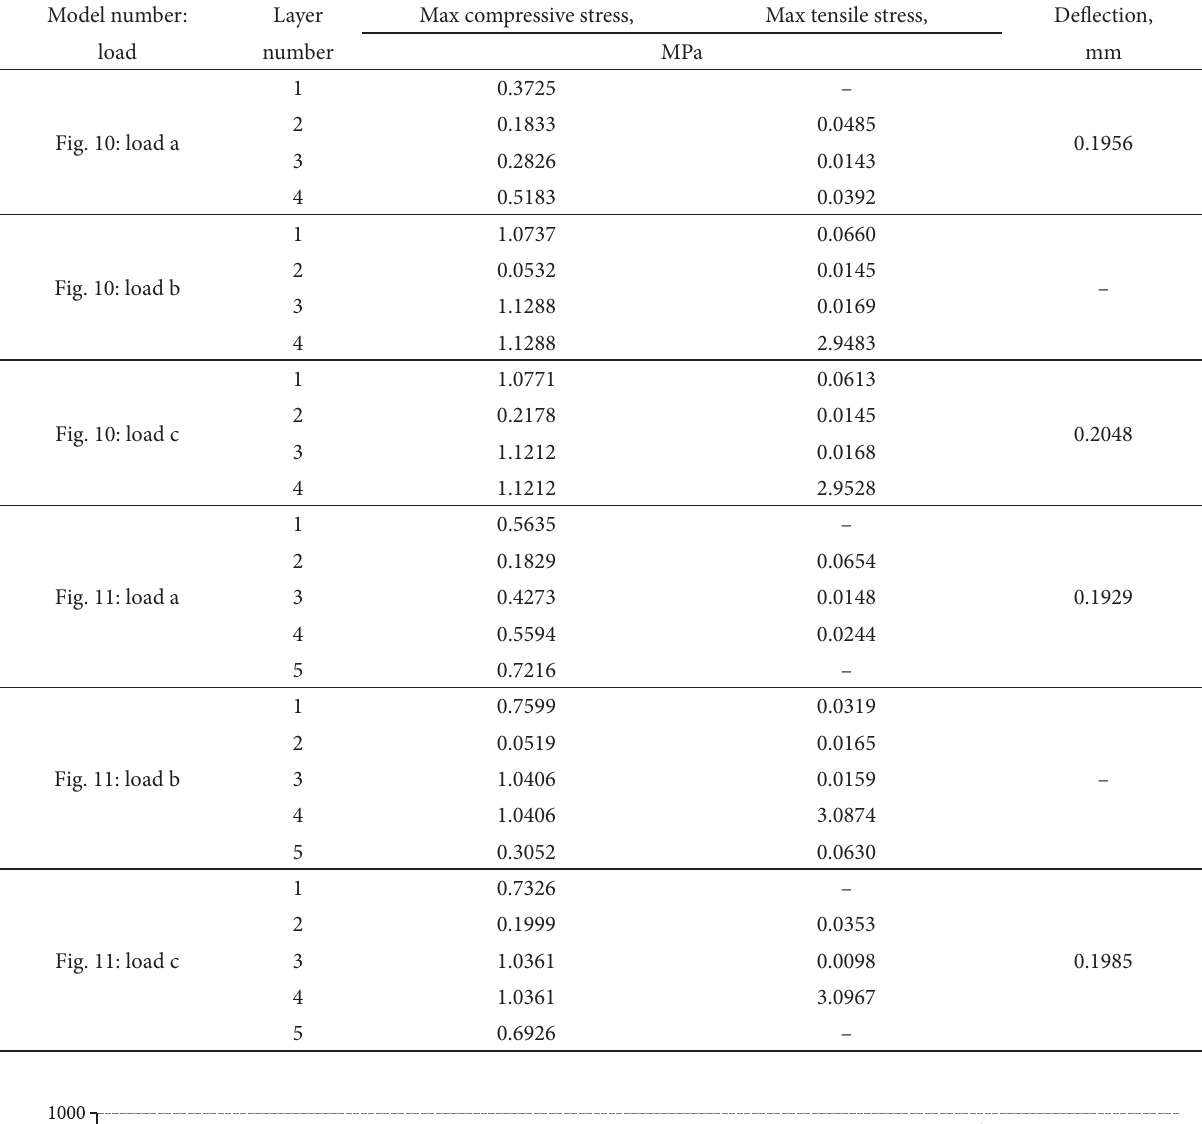
Table 5. Results of the mode of deformation research for schemes in Figs 10 and 11 Model number: